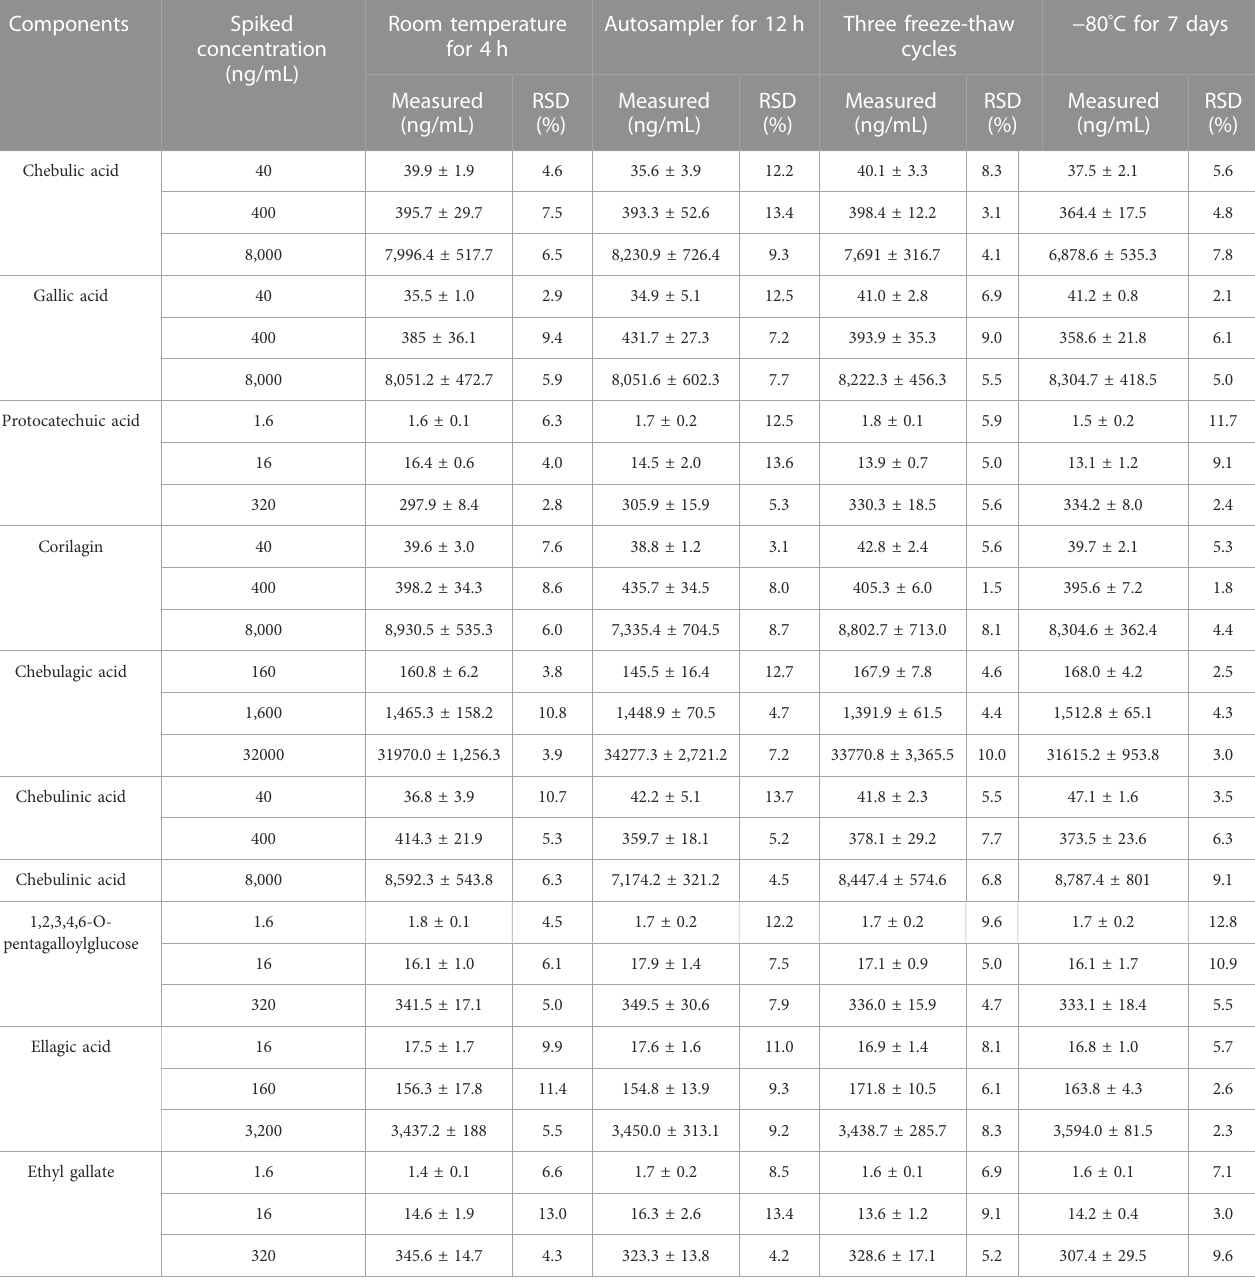
TABLE 6 Stability of nine analytes in rat plasma ( n = 6). Components Spiked